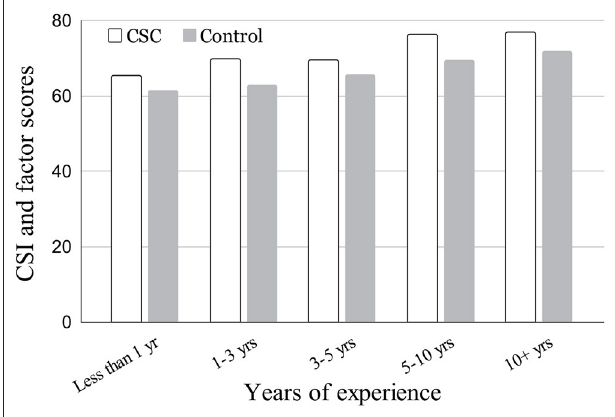
FIGURE 7 | CSI score distribution between groups by years of experience bracket in “arts and design” profession.